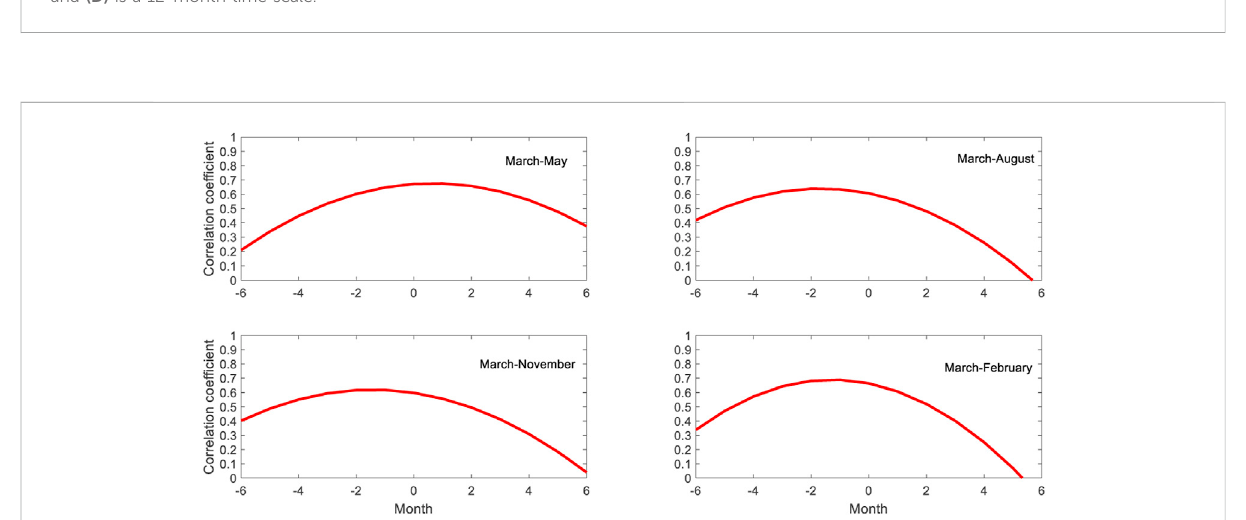
FIGURE 9 The Lead – lag correlation coef fi cient of the meteorological drought SPI index and the hydrological drought SDI index. “ March-August ” is a 3- month timescale, “ March-August ” is a 6-month timescale, “ March-November ” is a 9-month timescale, and “ March-February ” is a 12-month